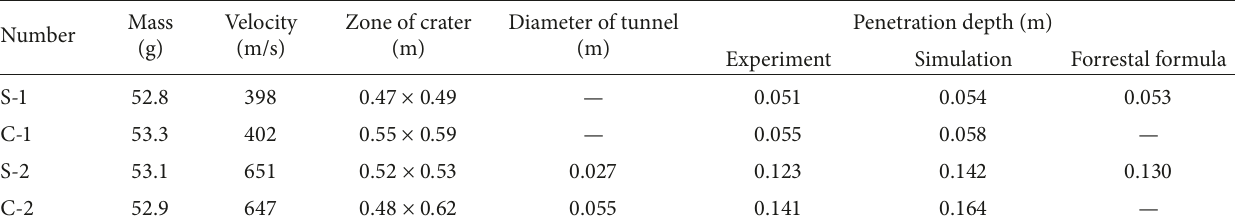
Table 2: The results of experiment and simulation.